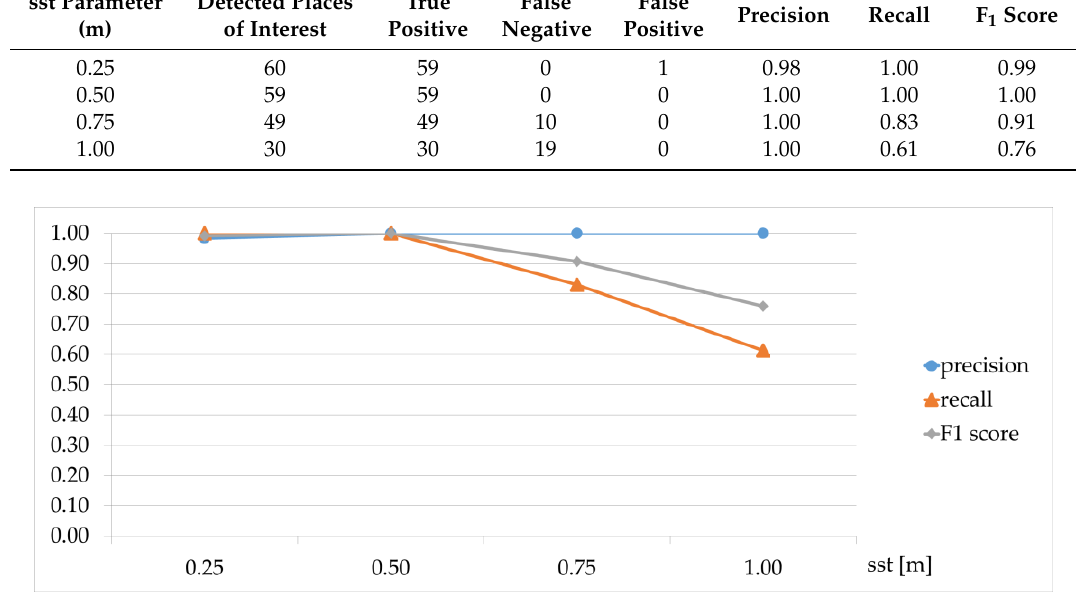
Table 3. Detection of the places of interest results according to various section step (sst) values. sst Parameter